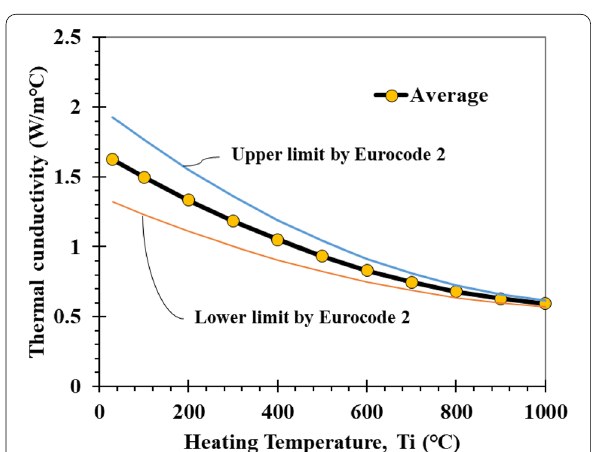
Fig. 22 Thermal conductivity variation of concrete (Eurocode 2).